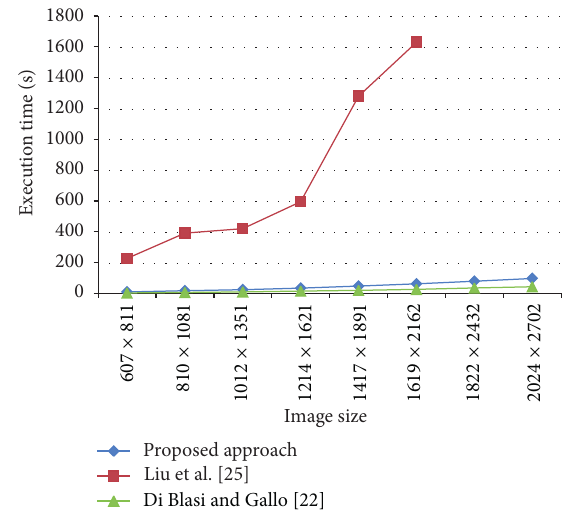
Figure 12: Execution time comparison at increasing image size.